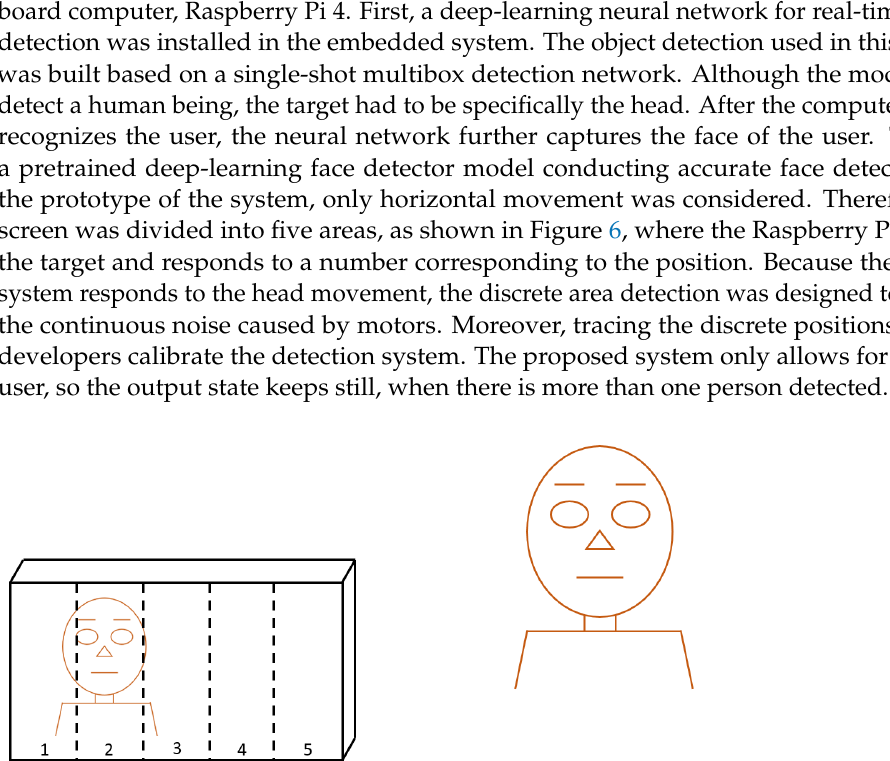
Figure 6. Screen divided into five sections to represent the coordinates by means of which the posi- tion of the listener head is detected.